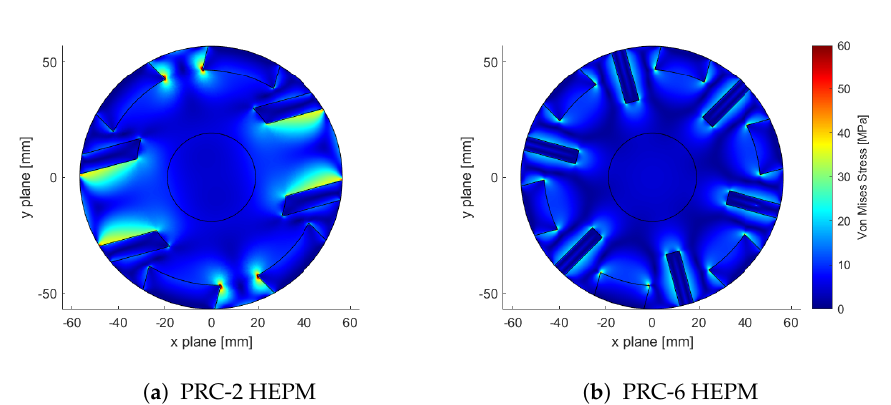
Figure 17. Mechanical stress of the PRC-2 and PRC-6 HEPM motors.